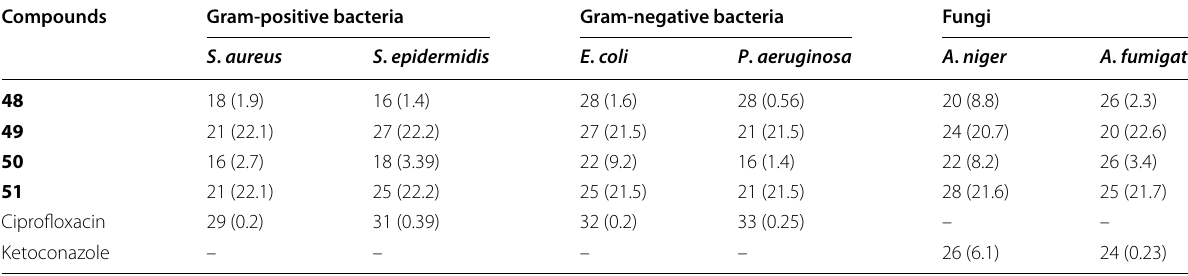
Table 15 In vitro activity zone of inhibition (mm) of compounds